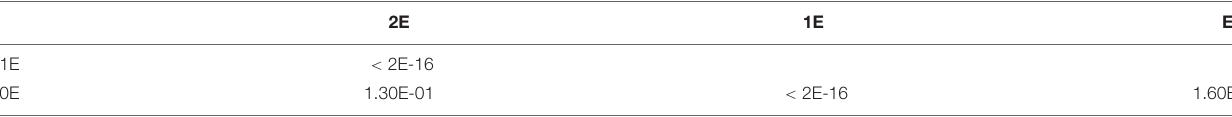
TABLE 2 | Pairwise comparisons using Wilcoxon rank sum test for the variable multiplication area ( p -values). 2E 1E E